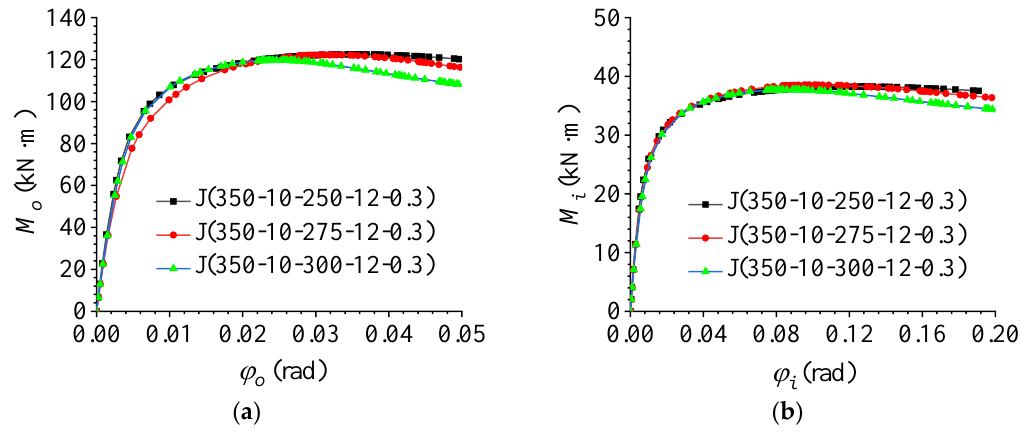
Figure 17. Effect of the radius of joint plate. ( a ) Out-of-plane M–φ curve; ( b ) in-plane M–φ curve.